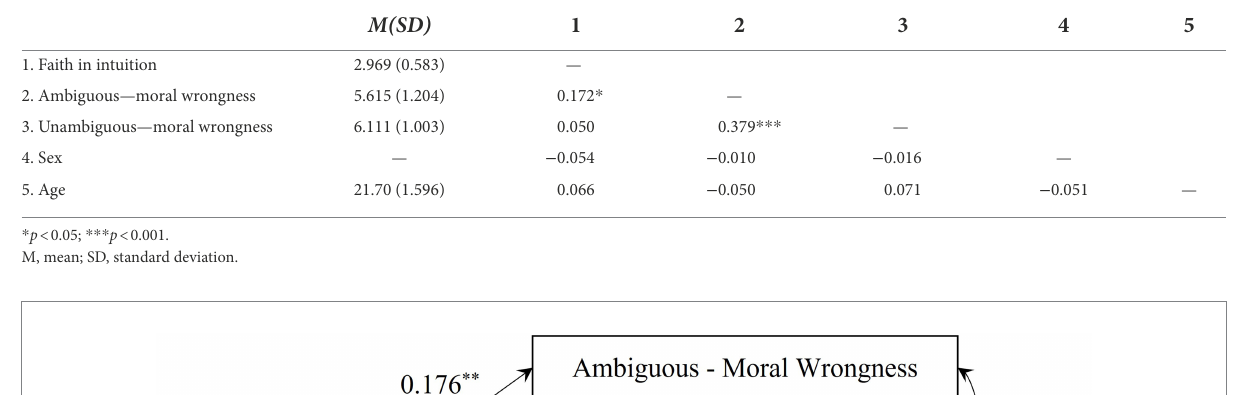
TABLE 1 Descriptive statistics and correlation analysis results of Experiment 1.